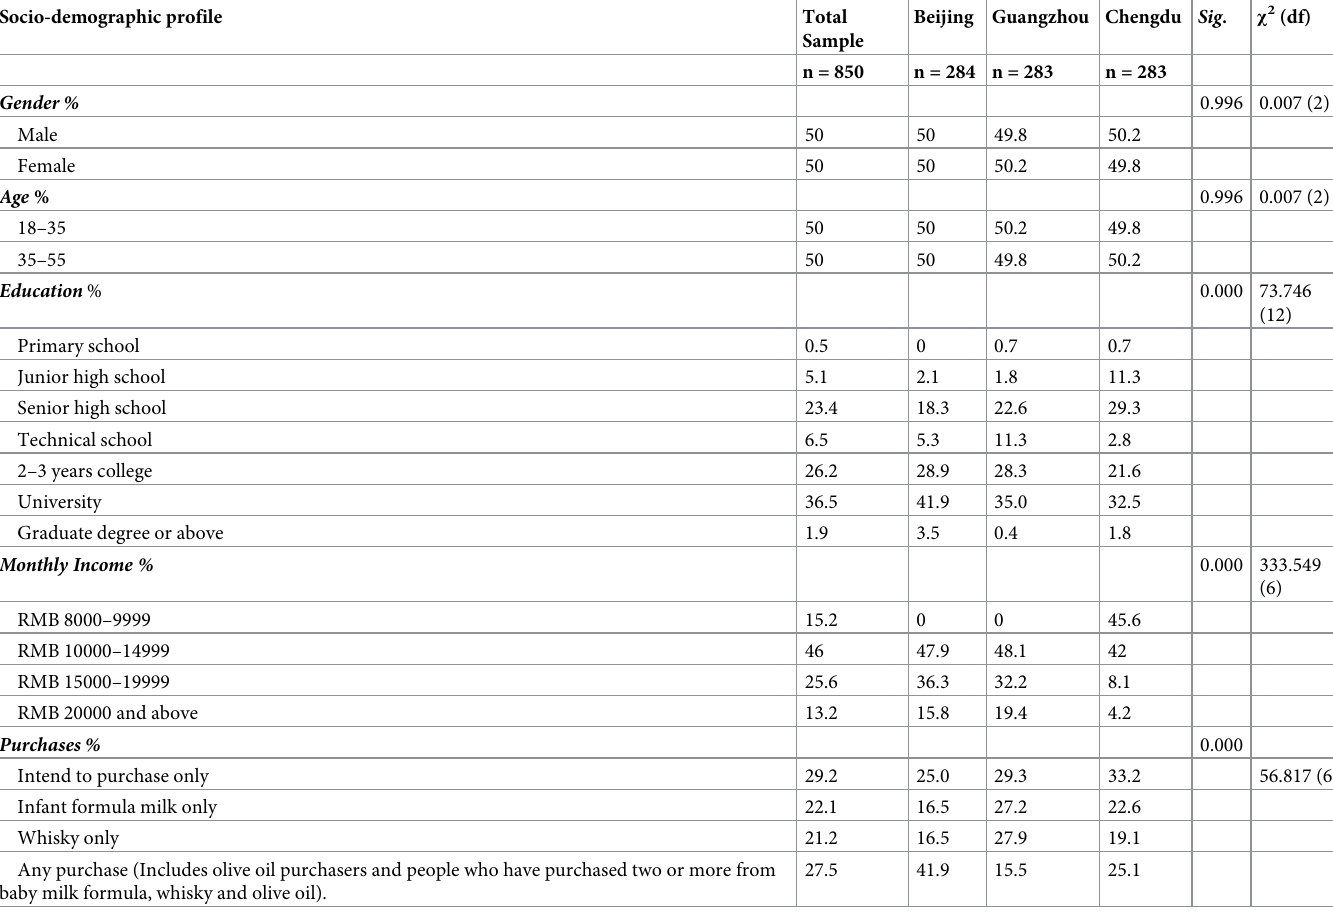
Table 5. Socio-demographic profile of the total sample and individual